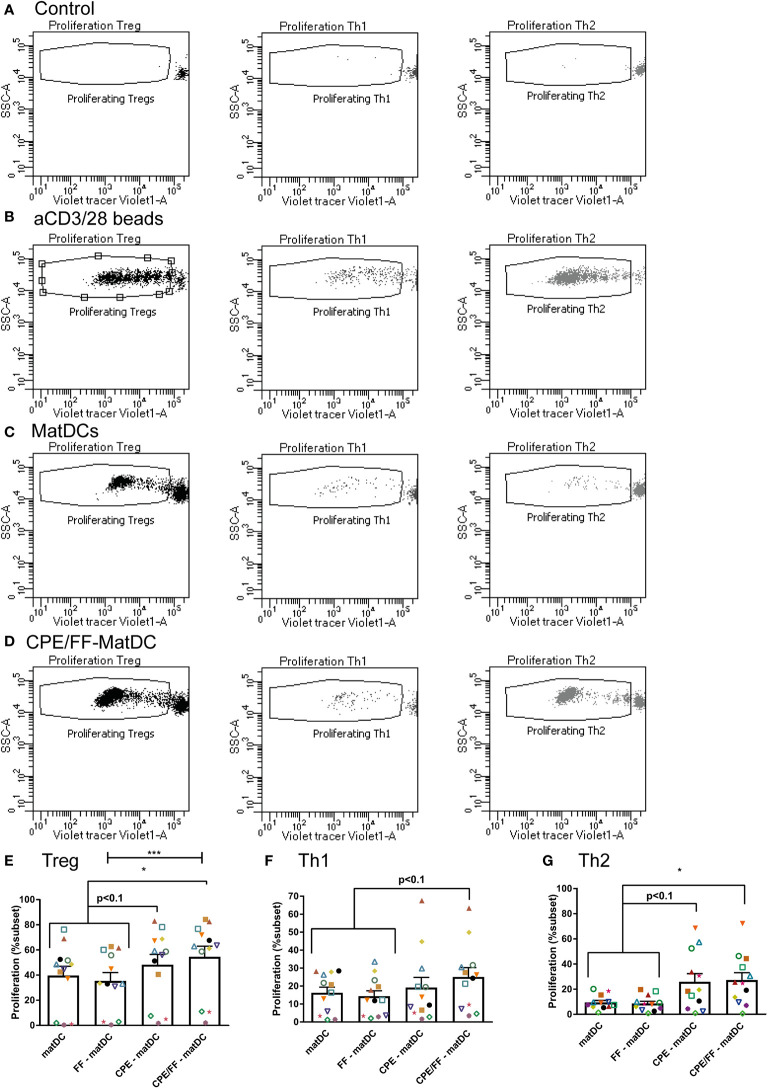
T cell proliferation Proliferation of the different subsets was identified as indicated (A–D). Treg proliferation was enhanced after co-culture with CPE/FF-matDCs, and exposure to CPE during DC maturation showed a similar trend (E). An increased trend in enhanced Th1 proliferation was also observed in T cells co-cultured with CPE/FF-matDCs (F). Th2 proliferation was significantly enhanced by co-culture with CPE/FF-matDCs, while co-culture with CPE-matDCs showed the same trend (G). Data are presented as mean ± SEM, *P<0.05, ***P<0.001, n=12. The different symbols and colors represent the measured values of independent peanut allergic donors.